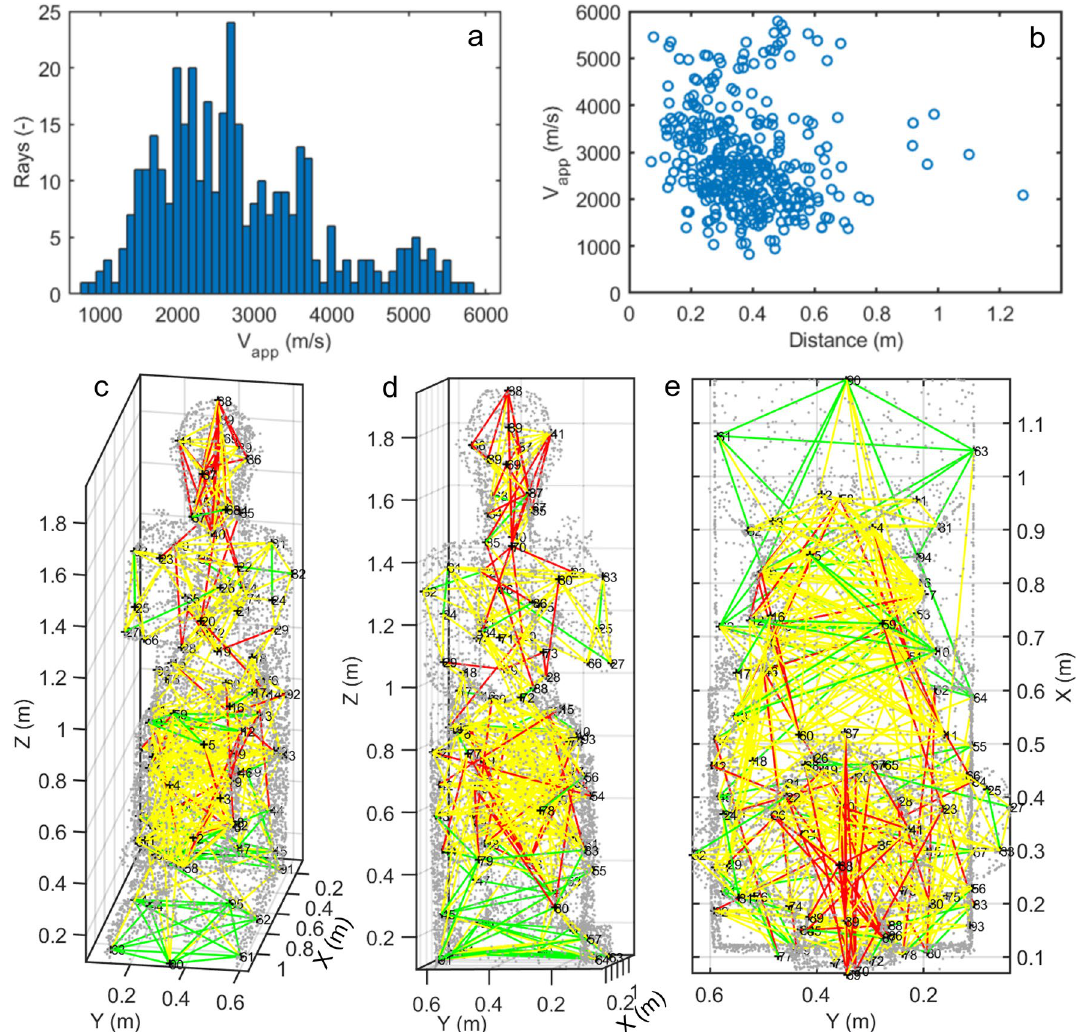
Figure 5. Apparent velocities obtained from the 3D ultrasonic measurements. ( a ) Histogram of the apparent velocity distribution (Vapp). ( b ) Apparent velocity values plotted as a function of the Euclidean source-receiver distance of the measured travel paths. ( c – e ) Measured paths with the classification of the apparent velocities in three classes: ( c ) frontal view, ( d ) view from the back, ( e ) view from the top. Figure created in Matlab (version R2021b, https:// it. mathw orks. com/ produ cts/ matlab.